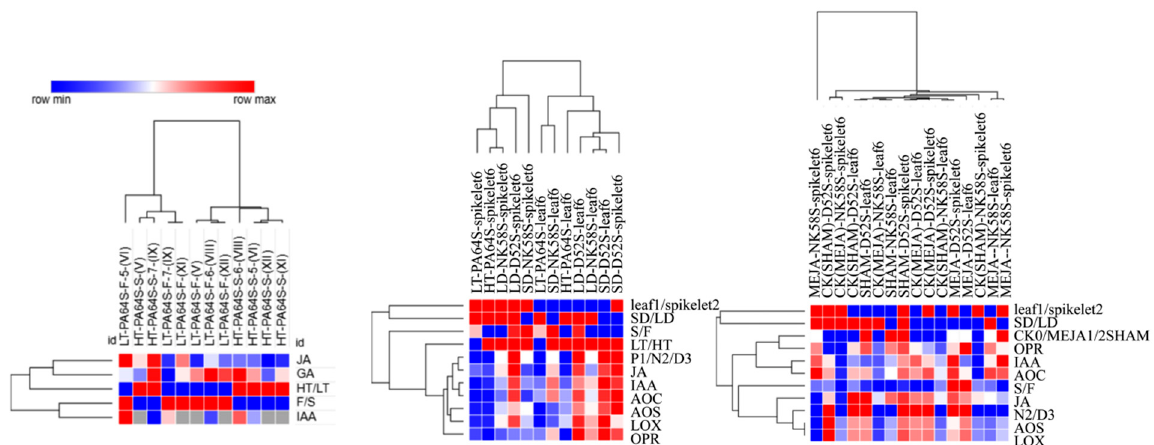
Figure 8. Heatmap analysis of hormone contents and JA synthesis enzyme activities in D52S, NK58S and PA64S. Data are from Figures 1, 2 and 5, and are treated for homogenization with maximum and minimum values of each indicator marked in red to blue. LD, long-day cycle; SD, short-day cycle; HT, high temperature; LT, low temperature; MEJA, methyl jasmonate; SHAM, salicylhydroxamic acid; CK, control; S/F/R, sterile/fertile/fertility-reverse plants; 5/6/7, 5th/6th/7th- stage.